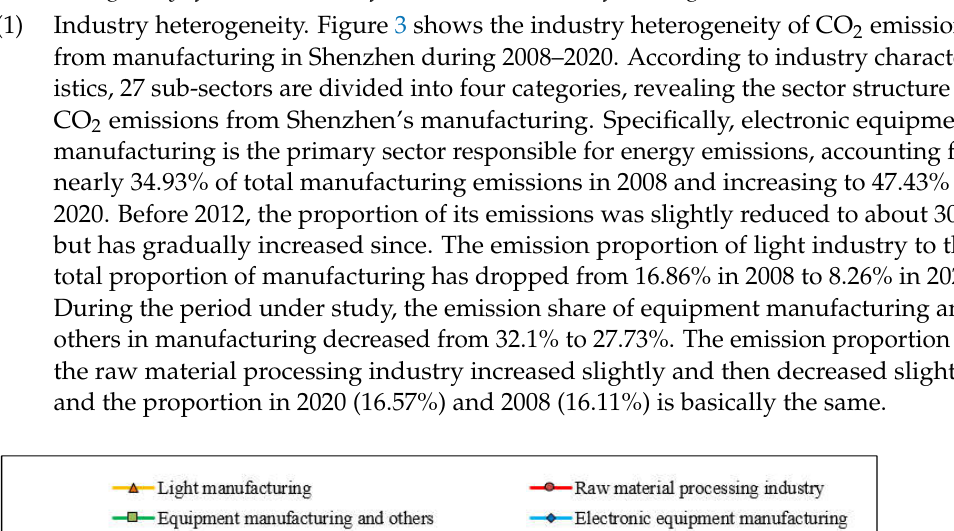
Table 5. The proportion of CO 2 emissions embodied in electricity to total emissions in 27 manufac- turing subsectors (%). Sector